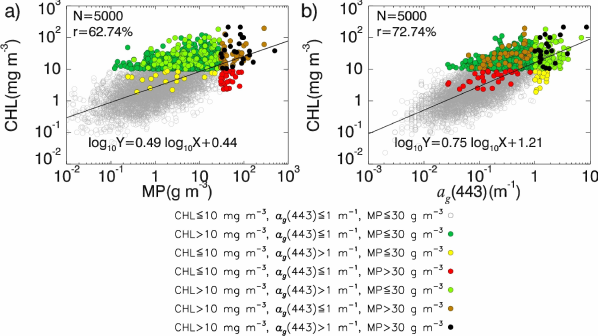
Figure 6. The distribution of (a) water depth (m), (b) temperature ( ◦ C), and (c) salinity (psu) as given in the in situ data set at all avail- able depths. The black boxes delimit the 25th and 75th percentiles of the data and the black horizontal lines show the extension of up to the 5th and 95th percentiles. The green line represents the me- dian value and the blue (red) “ + ” the minimum (maximum) plot values below (above) the 5th (95th) percentile. The number of mea- surements taken at each test site is reported on the right axis of the graph. The scale is logarithmic for the water